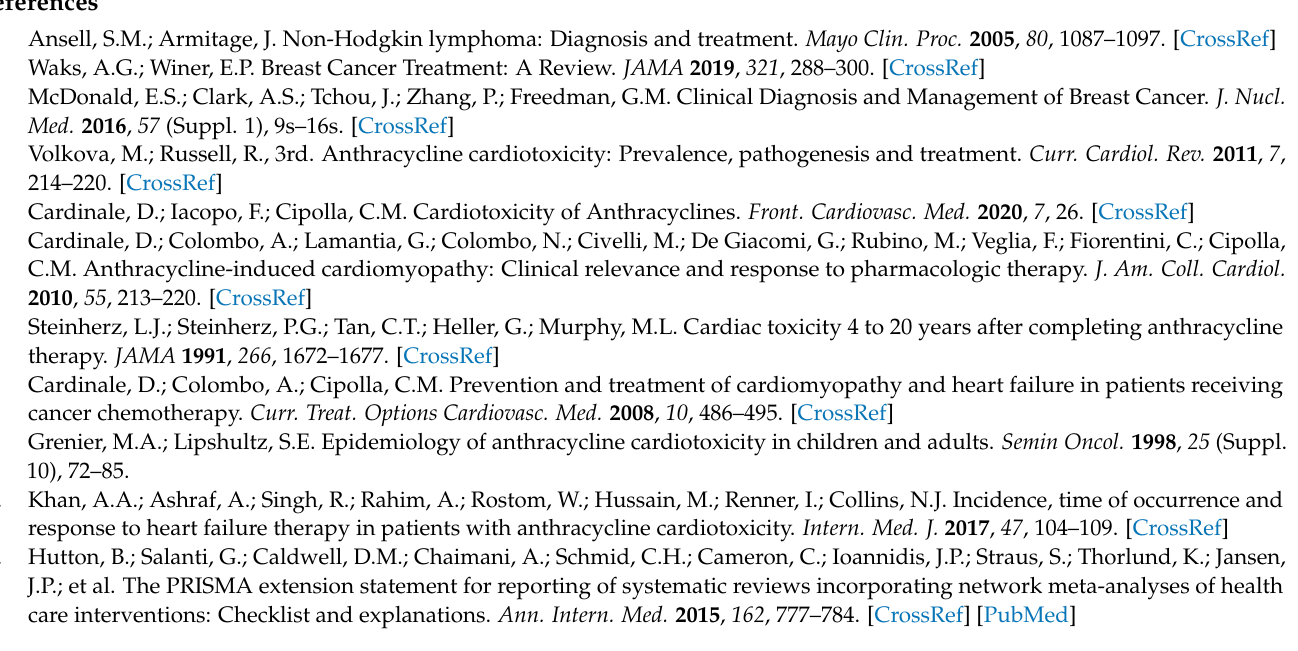
Table S3: Details of outcome assessment; Table S4: Subgroup analyses of cumulative decline in left ventricular ejection fraction (%) over time in cohorts of cancer patients receiving a cumulative anthra- Table S5: Subgroup analyses of cumulative decline in left ventricular ejection fraction (%) over time in cohorts of cancer patients (A) with a baseline LVEF of 65 to 70% (B) with a baseline LVEF of 60 to 65%; Table S6: Subgroup analyses of cumulative decline in left ventricular ejection fraction (%) over time in cohorts of cancer patients, excluding studies with at least 10% of cancer patients receiv- ing trastuzumab; Table S7: Cumulative rise in natriuretic peptides (standardised mean) over time; Figure S1: Risk of bias assessment; Figure S2: Cumulative rise in natriuretic peptides (standardised mean) over time. Whiskers represent 95% confidence